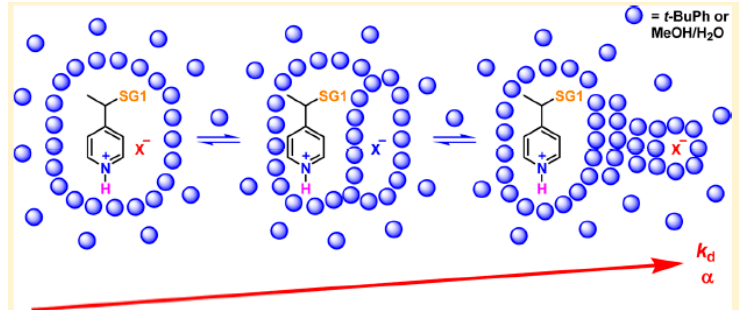
Figure 17. Cartoon representation of the impact of a solvent on an intimate ion pair. Reprinted with permission from Ref. [51] . Copyright 2013 American Chemical Society.